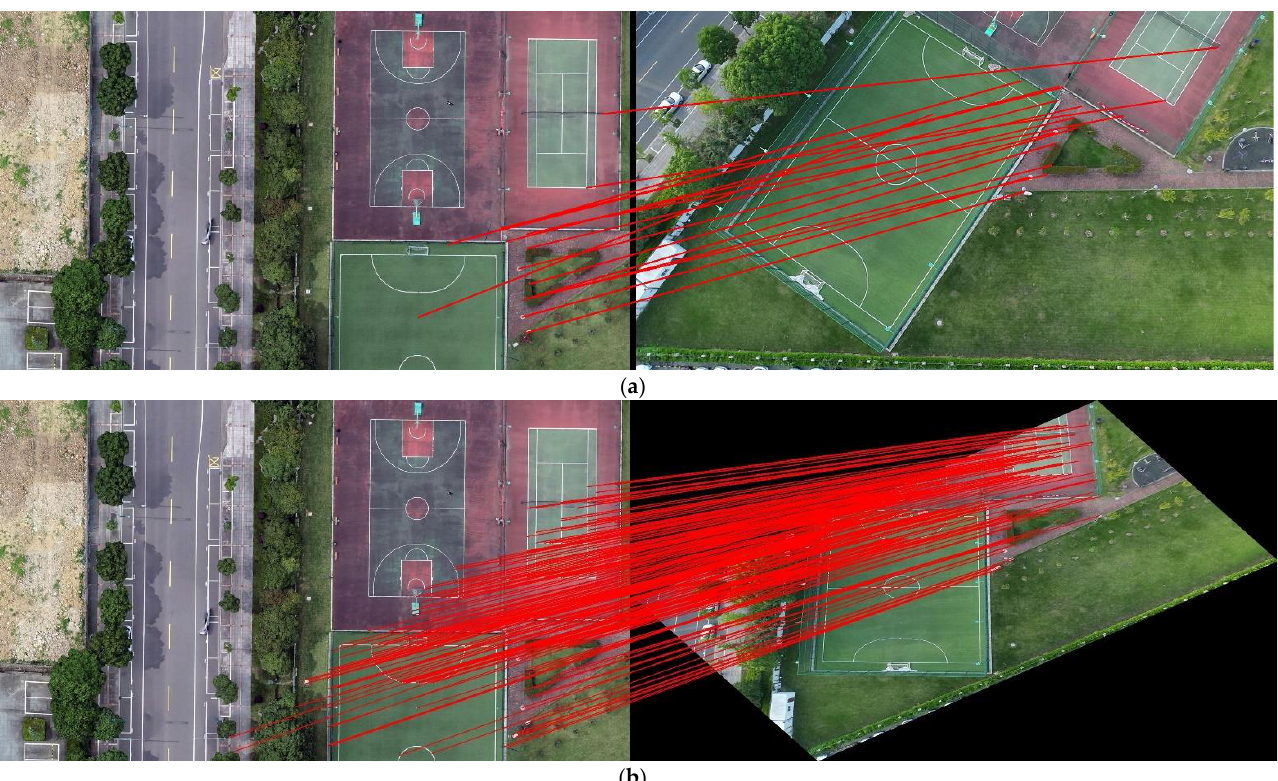
Figure 13. Matching effects prior to and following image rotation: ( a ) matching effect prior to rotation; ( b ) matching effect following rotation. Table 4. Number of the matching points before and after rotation .The better results are high- lighted in bold.